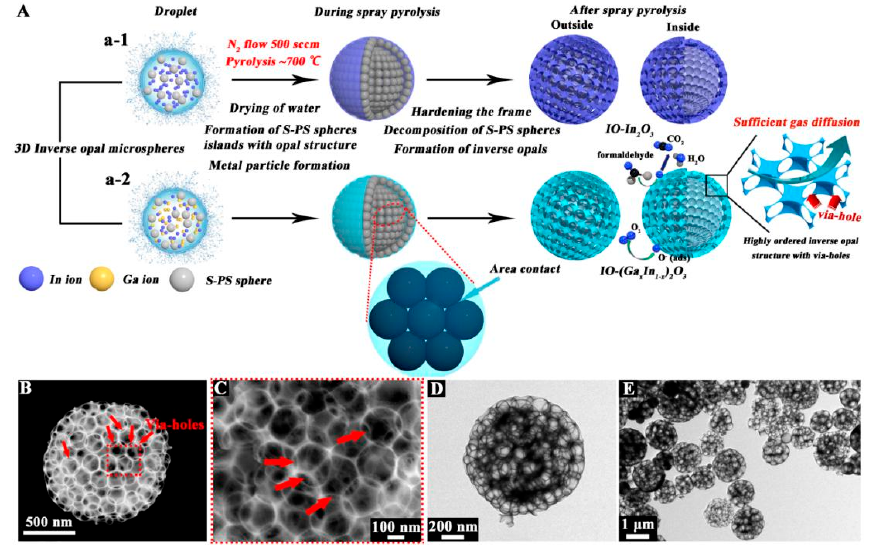
Figure 1. ( A ) Schemes illustrating the preparation of (a-1) inverse opal-In 2 O 3 (IO-In 2 O 3 ) microspheres, (a-2) Ga-doped IO-In 2 O 3 microspheres (IO-(Ga 0.2 In 0.8 ) 2 O 3 ); ( B and C ) SEM and ( D and E ) TEM images of IO-(Ga 0.2 In 0.8 ) 2 O 3